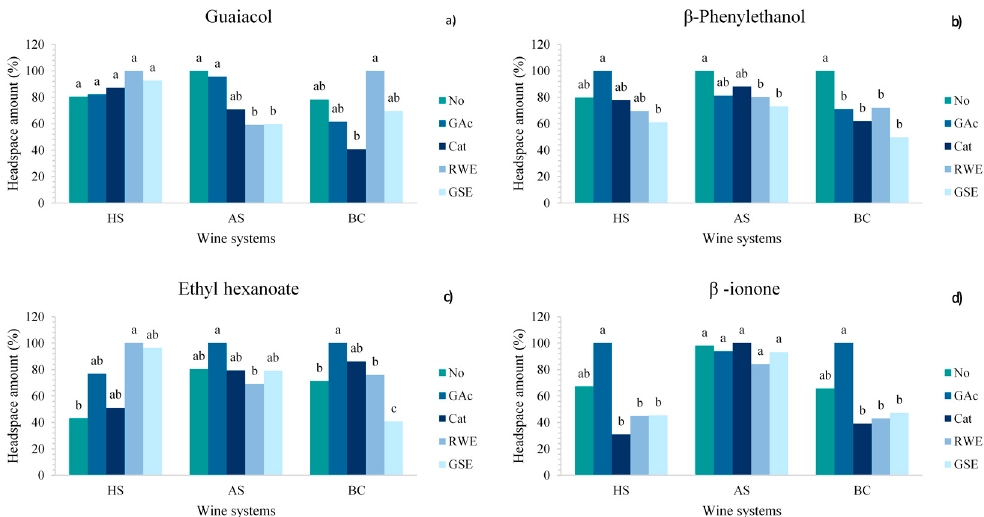
Figure 3. E ff ect of phenolic compounds (No: without polyphenol, GAc: gallic acid, Cat: catechin, RWE: red wine extract, GSE: grape seed extract) on wine aroma volatility. For each aroma compound, ( a ) Guaiacol, ( b ) β -Phenylethano, ( c ) Ethyl hexanoate and ( d ) β -Ionone, and type of wine system, di ff erent letters on the top of the bars denote significant di ff erences among wines spiked with di ff erent polyphenols ( p < 0.05) from Tukey test.